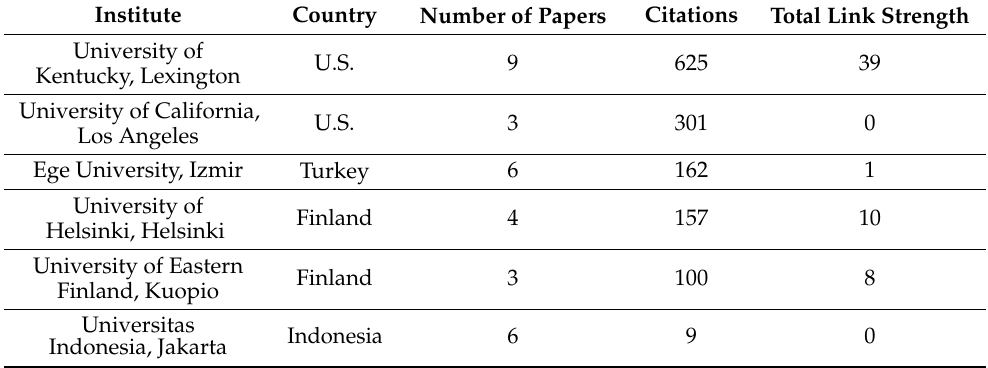
Table 3. Displaying leading institutes that published the most within the field of salivary biomarkers.